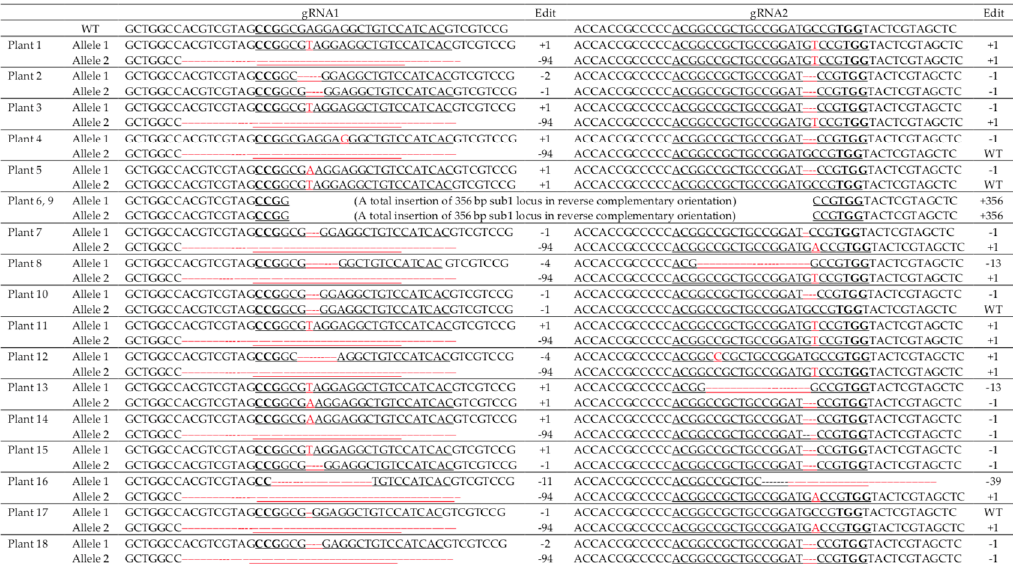
Figure 3. Sanger sequencing results of transgenic plants derived from immature embryo transformation. Two gRNAs are underlined. PAM sequences are highlighted in bold. gRNA1: 5 ′ - CCG GCGAGGAGGCTGTCCATCAC-3 ′ ; gRNA2: 5 ′ -ACGGCCGCTGCCGGATGCCG TGG -3 ′ . gRNA1 and gRNA2 are 350 bp apart. "WT" indicates that the allele was not edited (wild type).